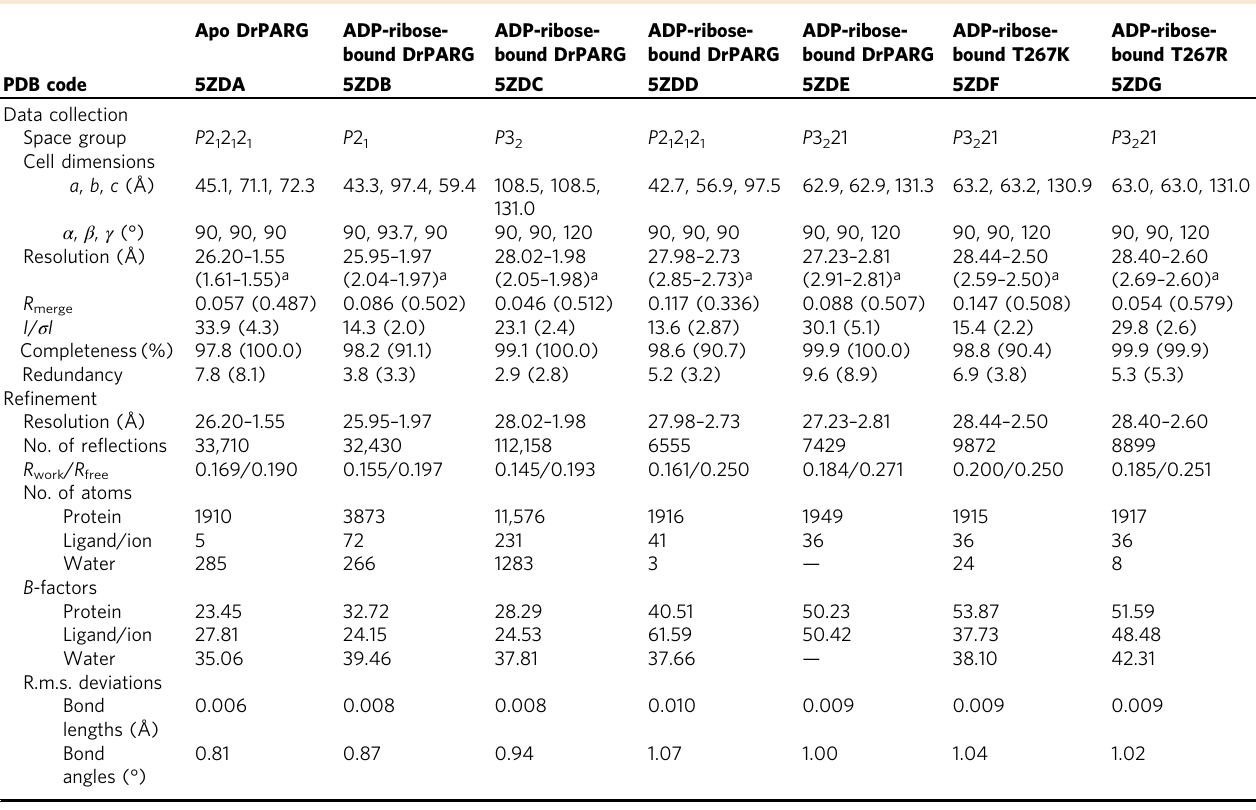
Table 1 Data collection and re fi nement